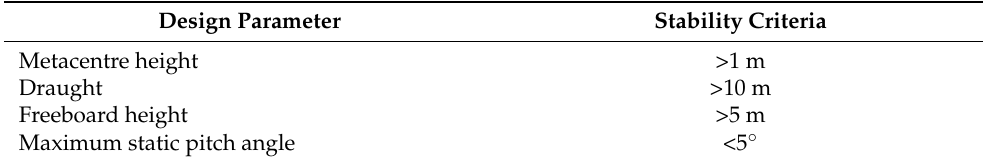
Table 3. Design constraints for the floating offshore platforms [92].